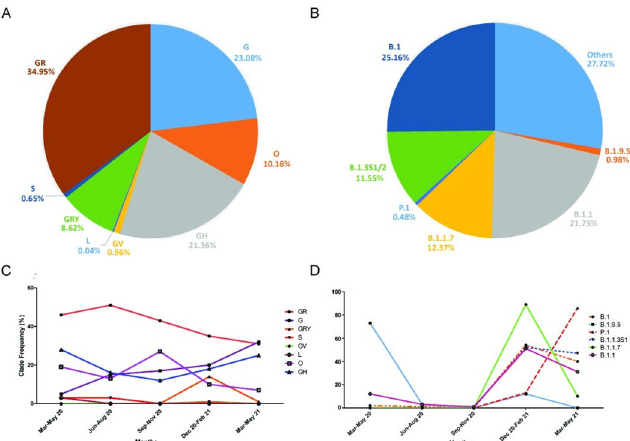
Fig 1. Distribution of clades and lineages among 4607 genomes. (A) Pie chart of the most common GISAID clades [15] (B) Pie chart of the most common lineages. (C) Line graph of clade frequencies comparisons with different periods of the pandemic. (D) Line graph of lineage frequencies comparison with different timelines of the pandemic. B.1.1.7; UK variant, P.1; Brazil variant, B.1.351/2; South Africa variant.